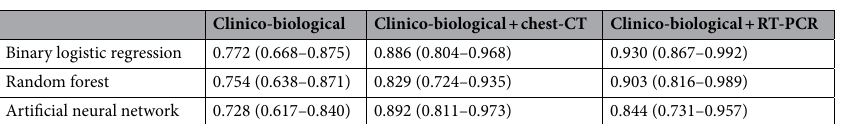
Table 3. AUC for each machine learning model. Three model types were constructed: binary logistic regression, random forest, and artificial neural network. Each model was trained with three sets of